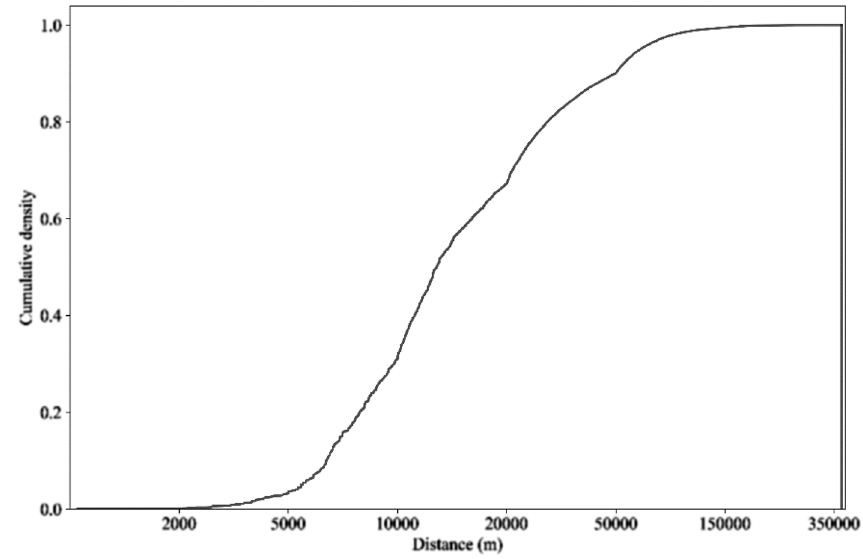
Figure 3. Distribution of travel distances of all individuals.